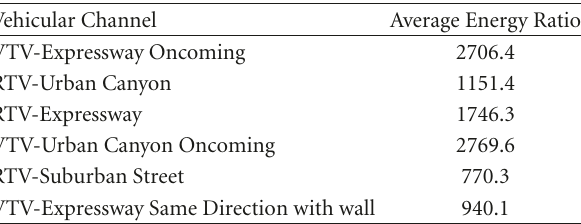
Figure 13: BER/PER when transmitting with and without coding through VTV-Expressway Same Direction with Wall . Table 7: Energy ratios for the vehicular channels.